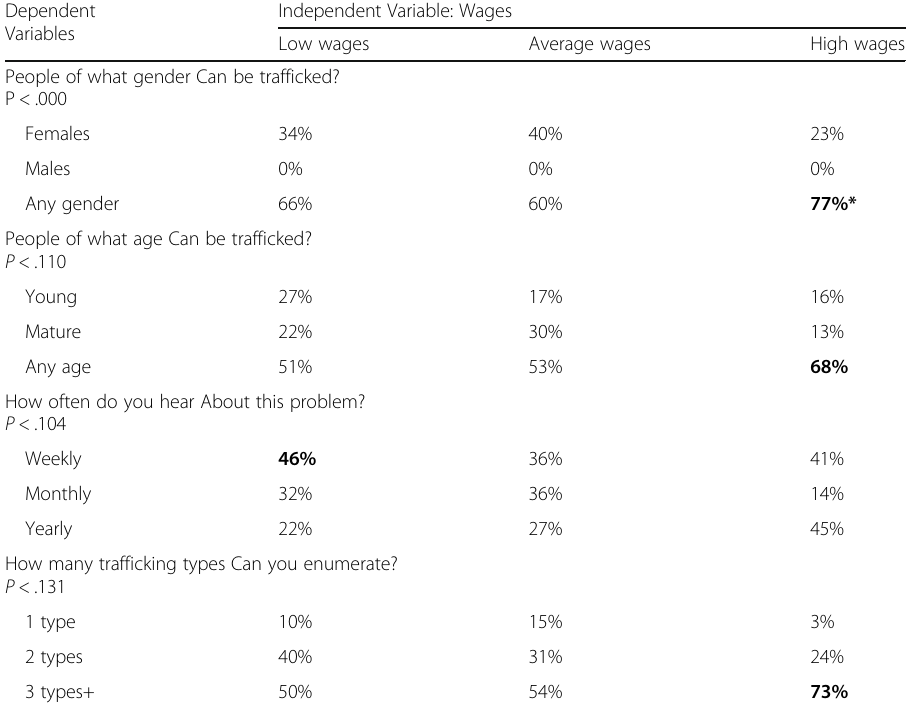
Table 4 Wages and knowledge about human trafficking Dependent Independent Variable: Wages Variables Low wages Average wages High wages People of what gender Can be trafficked? P < .000 Females 34% 40%